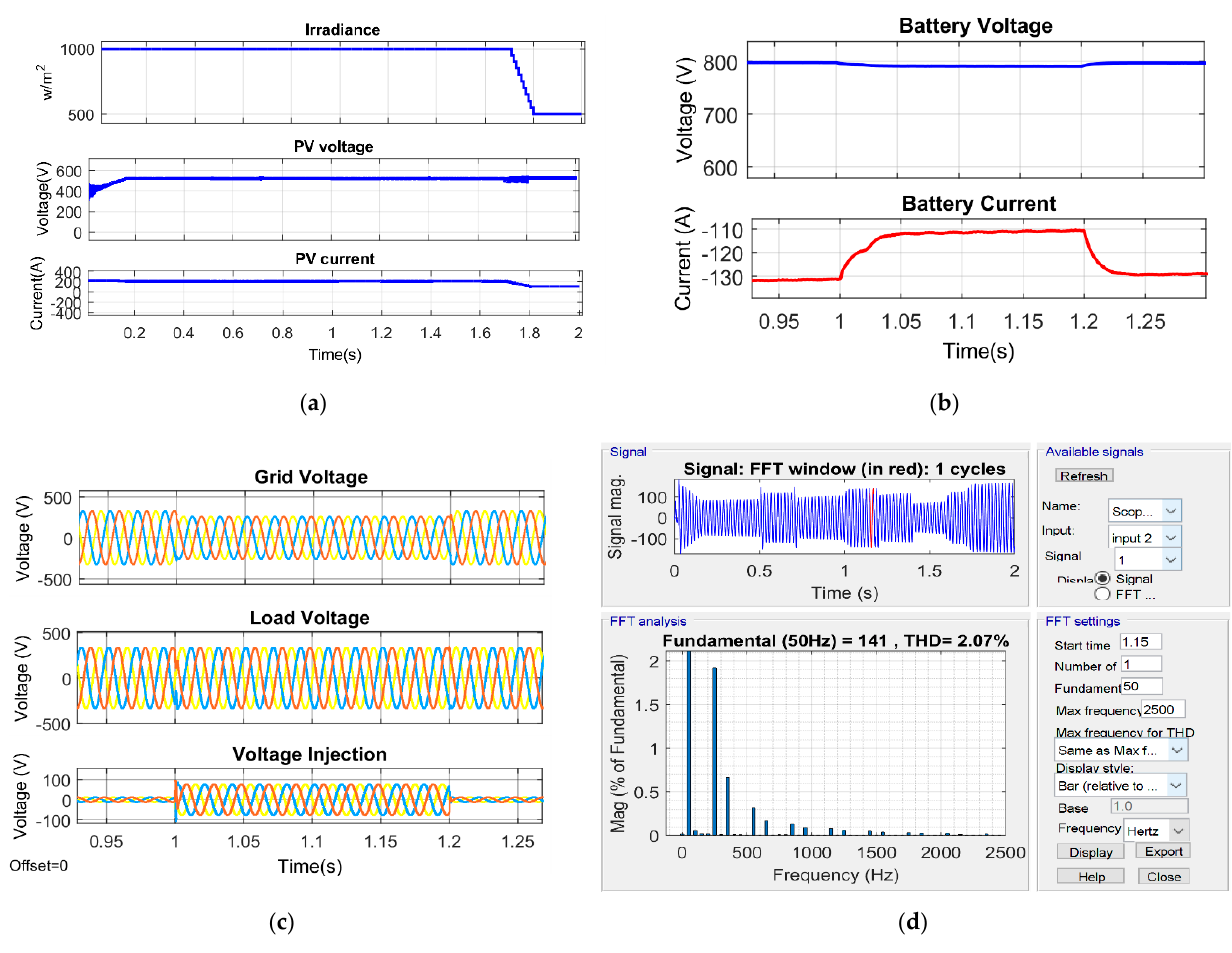
Figure 8. Response of the system parameters under voltage sag conditions. ( a ) Irradiance, PV voltage, power and current, ( b ) Battery voltage and current under voltage sag condition ( c ) Grid voltage, Load voltage and voltage injection under voltage sag condition ( d ) THD under voltage sag